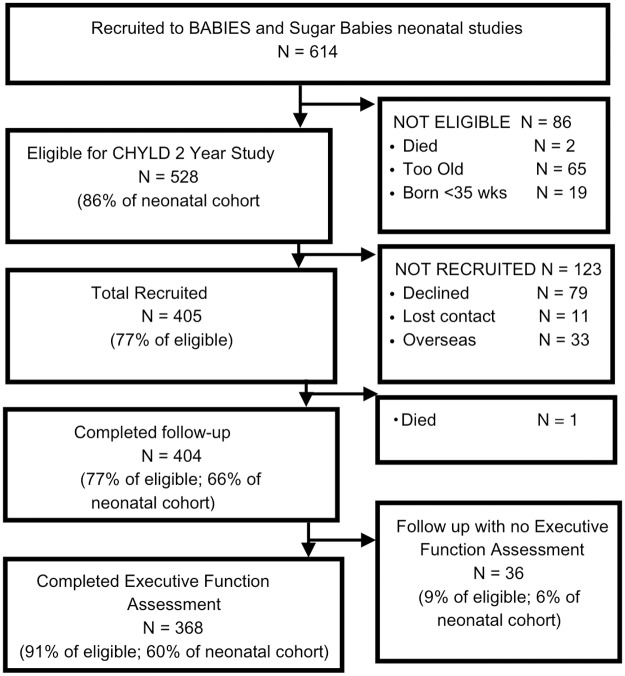
CHYLD study STROBE flow chart.